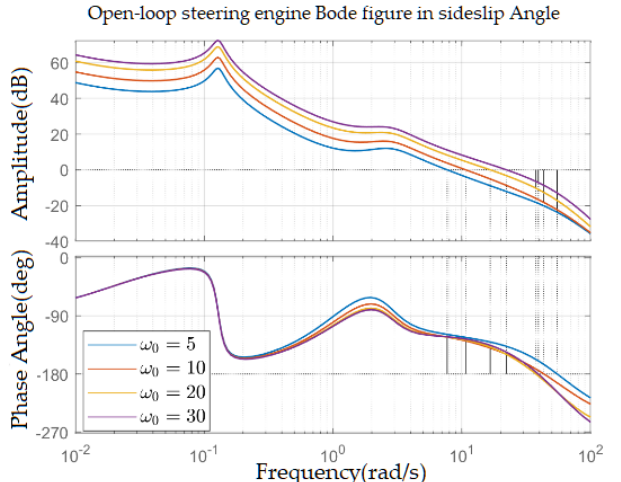
Figure 10. Open-loop Bode diagram at elevator of sideslip angle control loop.